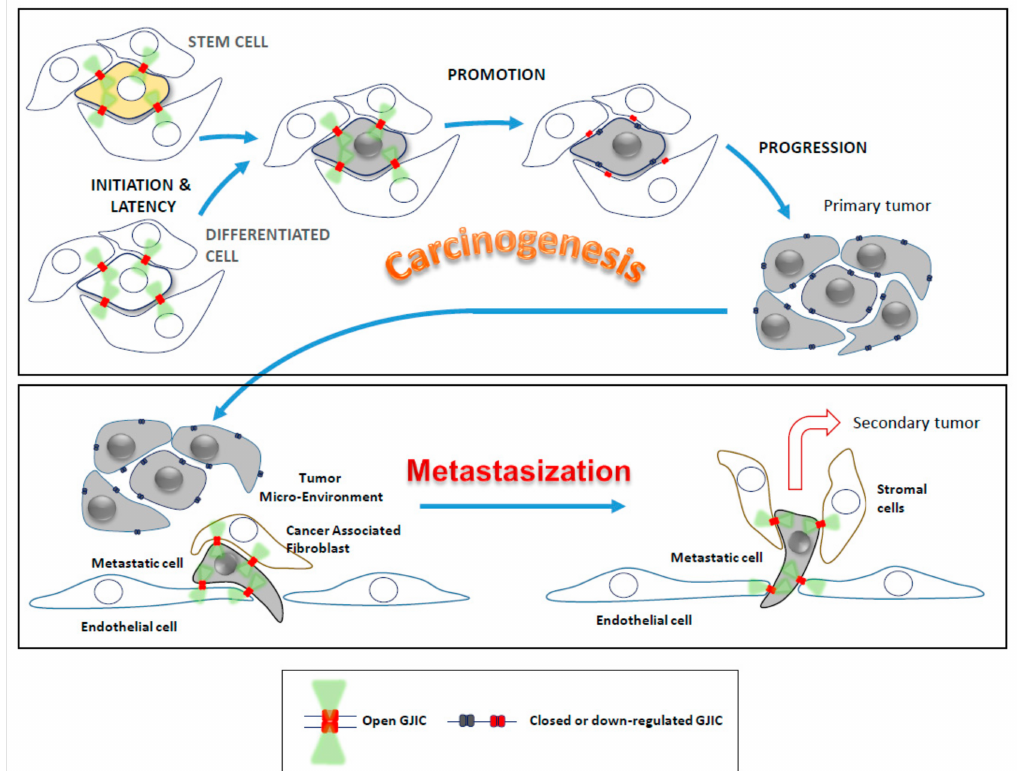
Figure 2. Di ff erent roles of GJIC in early and late phases of carcinogenesis involving either stem cells or di ff erentiated cells. Intact (not inhibited) GJIC acts as tumor suppressor in the initial stages of tumorigenesis, it is inhibited in the promoter phase, and it is reactivated (re-opened) during the metastasization stage. In migrating tumor cells, re-expression of Cxs promote tumor metastasis, enabling cell-to-cell communication between tumor cells and cancer-associated fibroblasts, as well as endothelial and stromal cells. The same might happen in the secondary